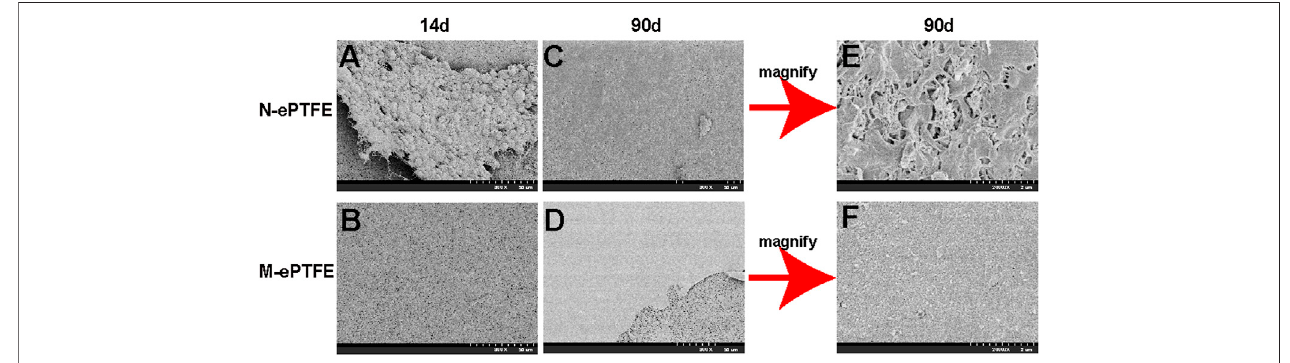
FIGURE5| Scanningelectronmicroscopyshowingthemorphologyofunmodi fi edN-ePTFE/M-ePTFE,expandedpolytetra fl uoroethyleneandmodi fi ed(M-ePTFE) at 14 d and 90 d post-implantation in rabbits. Scale bar of (A) – (D) = 50 μ m (2000×); Scale bar of (E,F) = 2 μ m (20000×).